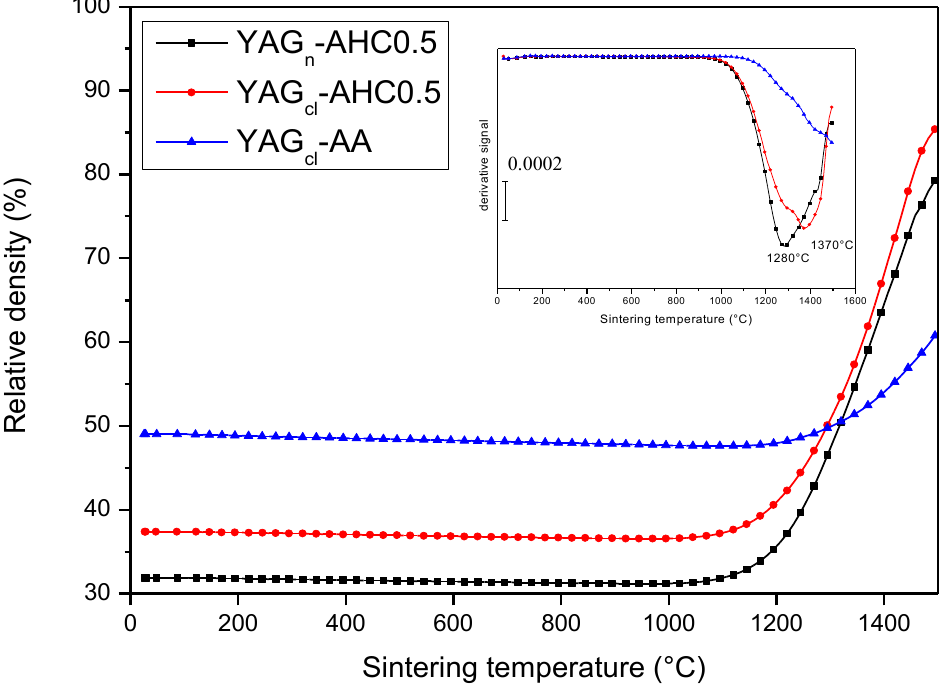
Figure 5. Relative density vs. sintering temperature of YAG cl -AA, YAG cl -AHC0.5 and YAG n -AHC0.5 samples. As an insert, the derivative signals of the same